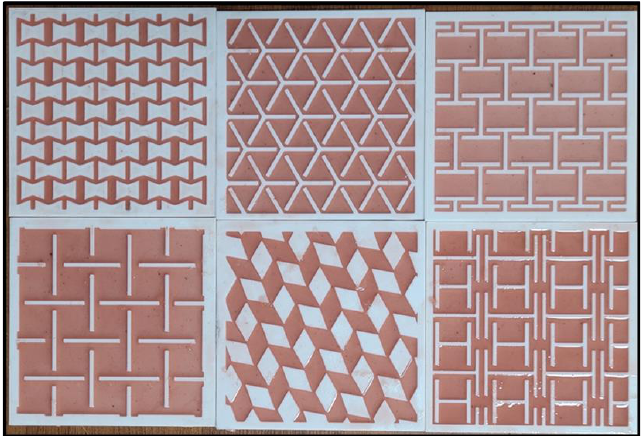
Figure 2. Three-dimensionally printed molds with silicone.